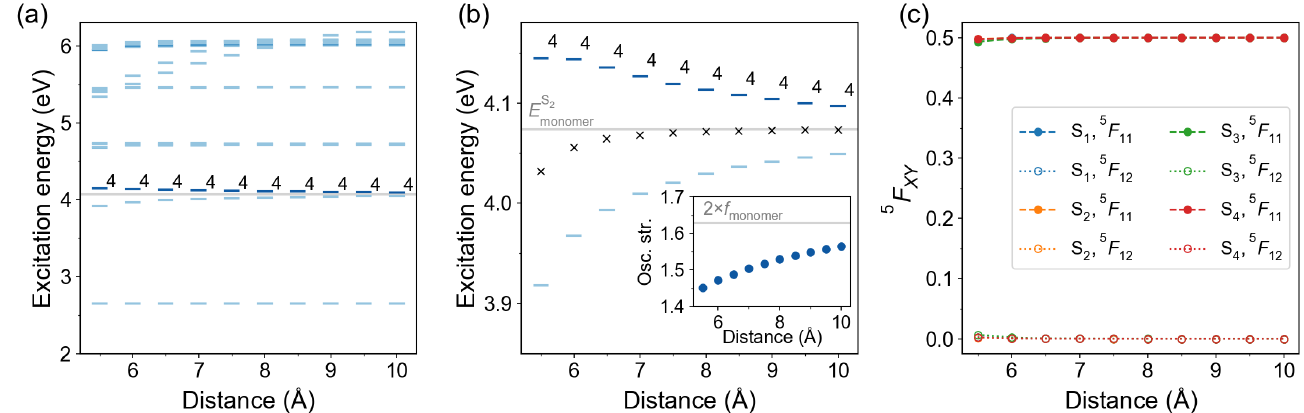
Figure 11. Distance dependence of excitation energies and FTDM matrix elements for in-plane azobenzene dimers. ( a ) Excitation energies of twenty lowest transitions. The bars are colored according to the oscillator strength of the transitions, with a darker color corresponding to a larger oscillator strength. The bright state labels are printed. The light grey line marks the excitation energy of the bright monomeric transition S 0 → S 2 . ( b ) Excitation energies of the lowest ππ ∗ + E S E S 3 states. Black crosses show the splitting center . The inset shows distance dependence of the oscillator strength of the 4 2 bright transition. The light grey line in the inset marks twice oscillator strength of the monomeric bright transition. ( c ) FTDM matrix elements 5 F 11 and 5 F 12 quantifying local and CT contributions, respectively, for the lowest four electronic